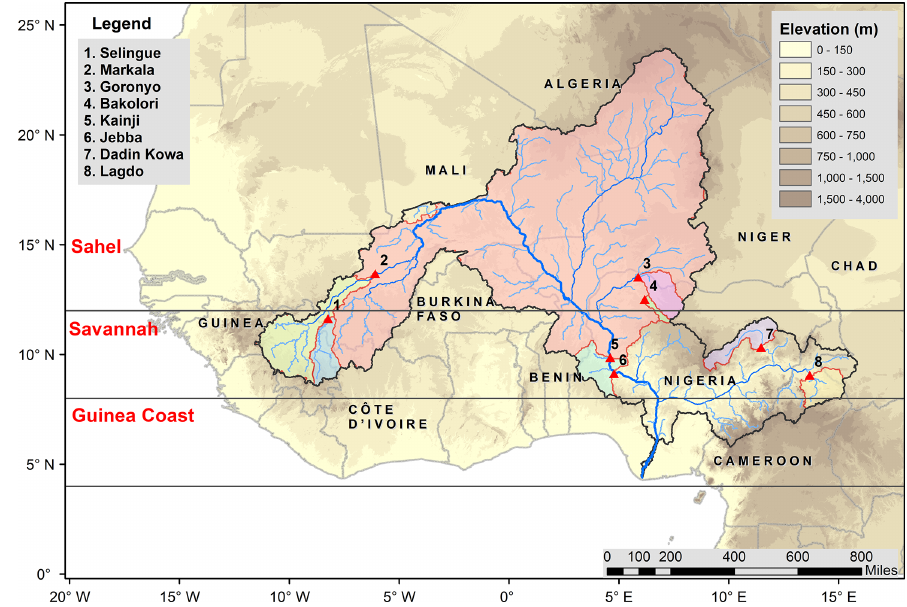
Figure 1. The Niger river basin and locations of major reservoir dams in the basin. (1) Selingue, (2) Markala, (3) Goronyo, (4) Bakolori, (5) Kainji, (6) Jebba, (7) Dadin Kowa, and (8) Lagdo.